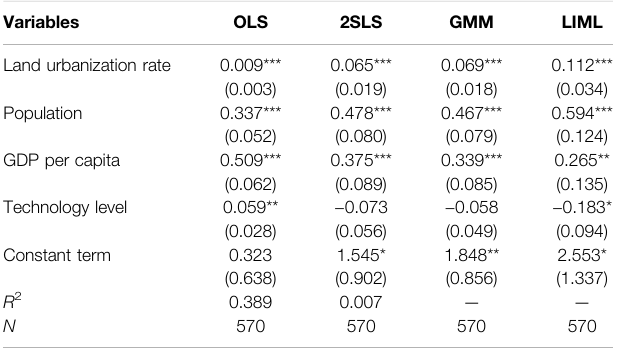
TABLE 3 | Estimating results between land urbanization and total CO 2 emissions based on the instrumental variable analysis.